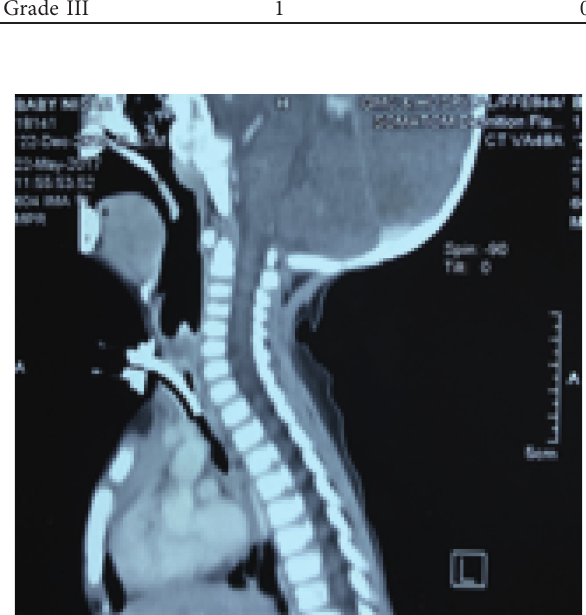
Figure 8: Preoperative sagittal CTimage with tracheostomy tube in situ.